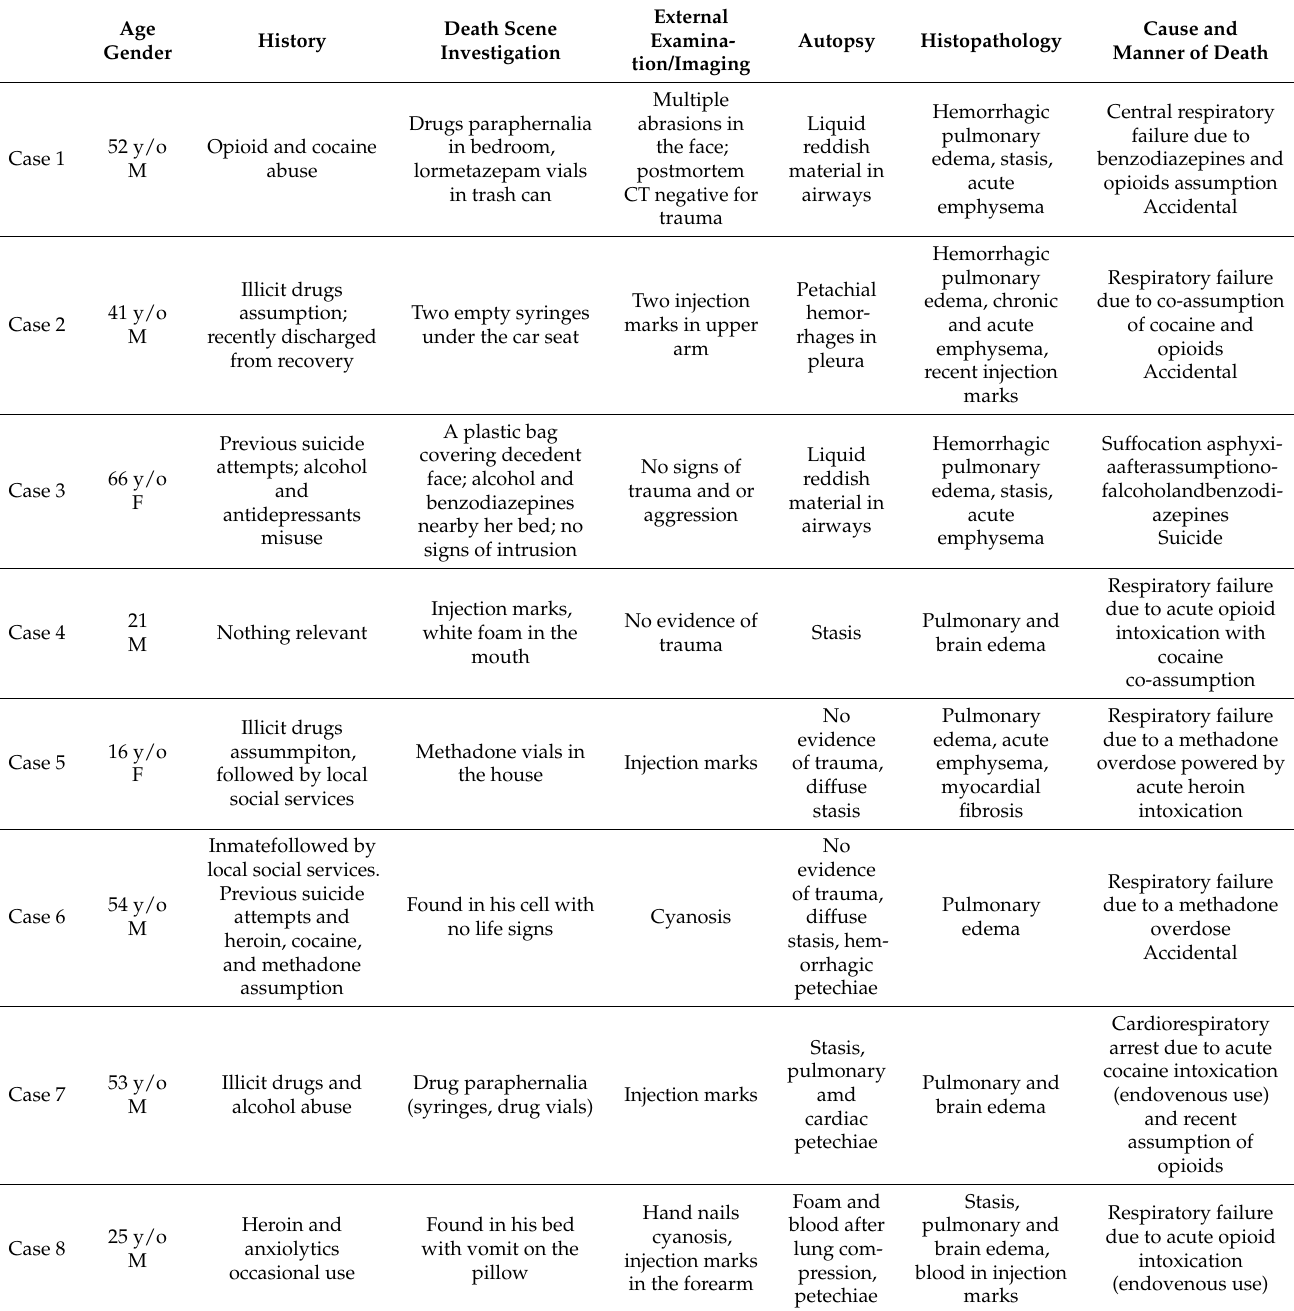
Table 1. A summary of the main findings of the selected